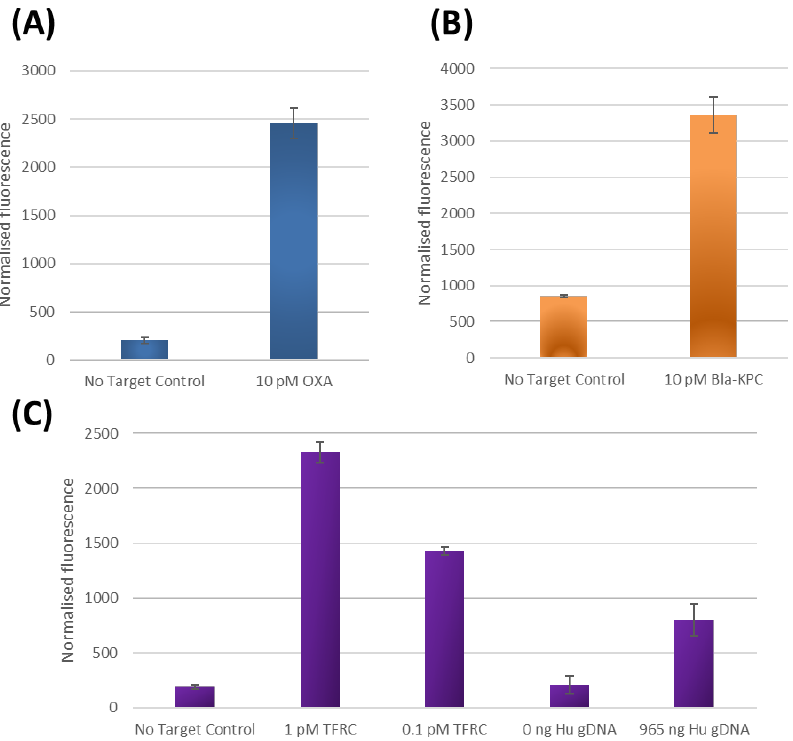
Figure 3. Results of three different Subzyme feedback reactions, (detailed in Figure 1B), where each reaction uses the same pair of cross-catalytic Subzymes, but each employs a different PlexZyme for detecting a different DNA target. Results are plotted as normalized fluorescence following a 20 min PMB incubation step and a 5 min fluorescence detection step by subtracting the RFU at 0 min from the RFU at 5 min. All data represent the average of two replicates. Results are shown for assays designed to detect oligonucleotide targets homologous to ( A ) bacterial OXA gene, ( B ) bacterial Bla-KPC gene and ( C ) human TFRC gene as well as detection of the TFRC gene present in human genomic DNA.